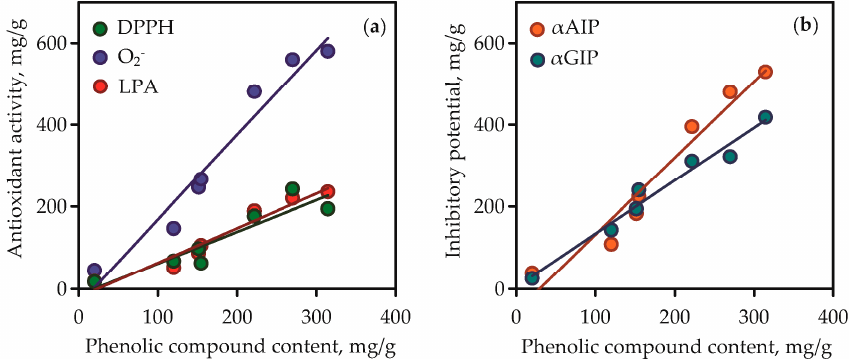
Figure 10. Correlation graphs between phenolic compound content in gentian extracts (mg/g) and their bioactivity. ( a ) DPPH—2,2-diphenyl-1-picrylhydrazyl radical scavenging activity (as mg of trolox per gram of dry extract weight; correlation equation y = 2.07 · x − 38.48, r = 0.9752); O 2- —superoxide anion-radical scavenging activity (as mg of quercetin per gram of dry extract weight; correlation equation y = 0.84 · x − 20.21, r = 0.9736); LPA—lipid peroxidation inhibition activity (as mg of ca ff eic acid per g of dry extract weight; correlation equation y = 0.76 · x − 14.74, r = 0.9232). ( b ) α AIP— α -amylase inhibitorypotential(asmgof acarbose pergofdryextractweight; correlationequation y = 1.86 · x − 54.73, r = 0.9739); α GIP— α -glycosidase inhibitory potential (as mg of acarbose per gram of dry extract weight; correlation equation y = 1.29 · x + 5.08, r =